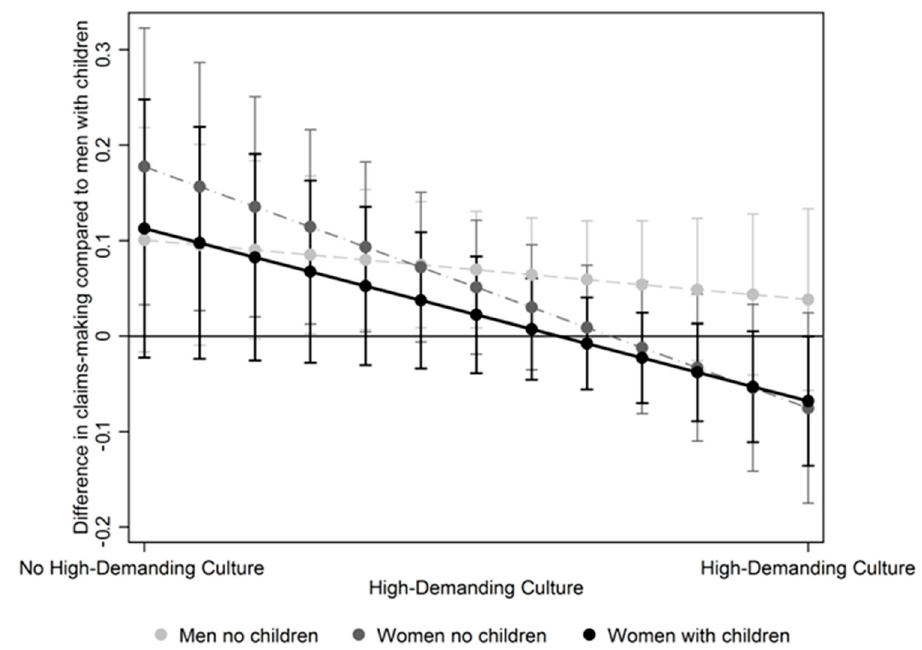
Figure 2. Gender differences in estimated values for claims-making according to highly demanding workplace culture. Note: Based on results model 1, Table 5. Figure shows interaction of high demanding workplace culture and family status; reference group: men with children; 90% Confidence Intervals, using stata-command contrast .